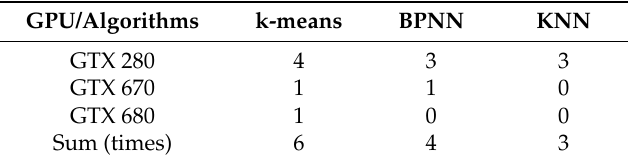
Table 5. Fault node information of original algorithms.